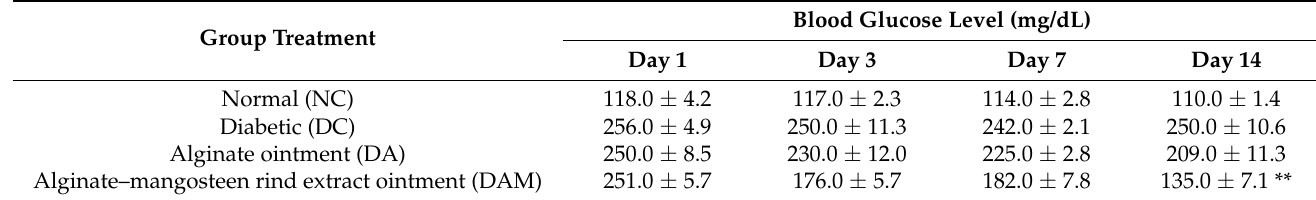
Table 2. Mean and standard deviation of blood